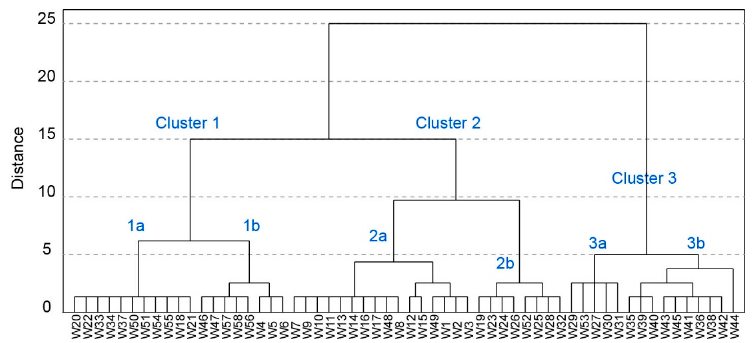
Figure 4. Dendrogram for the Hierarchical Cluster Analysis showing the three identified clusters and sub-clusters.